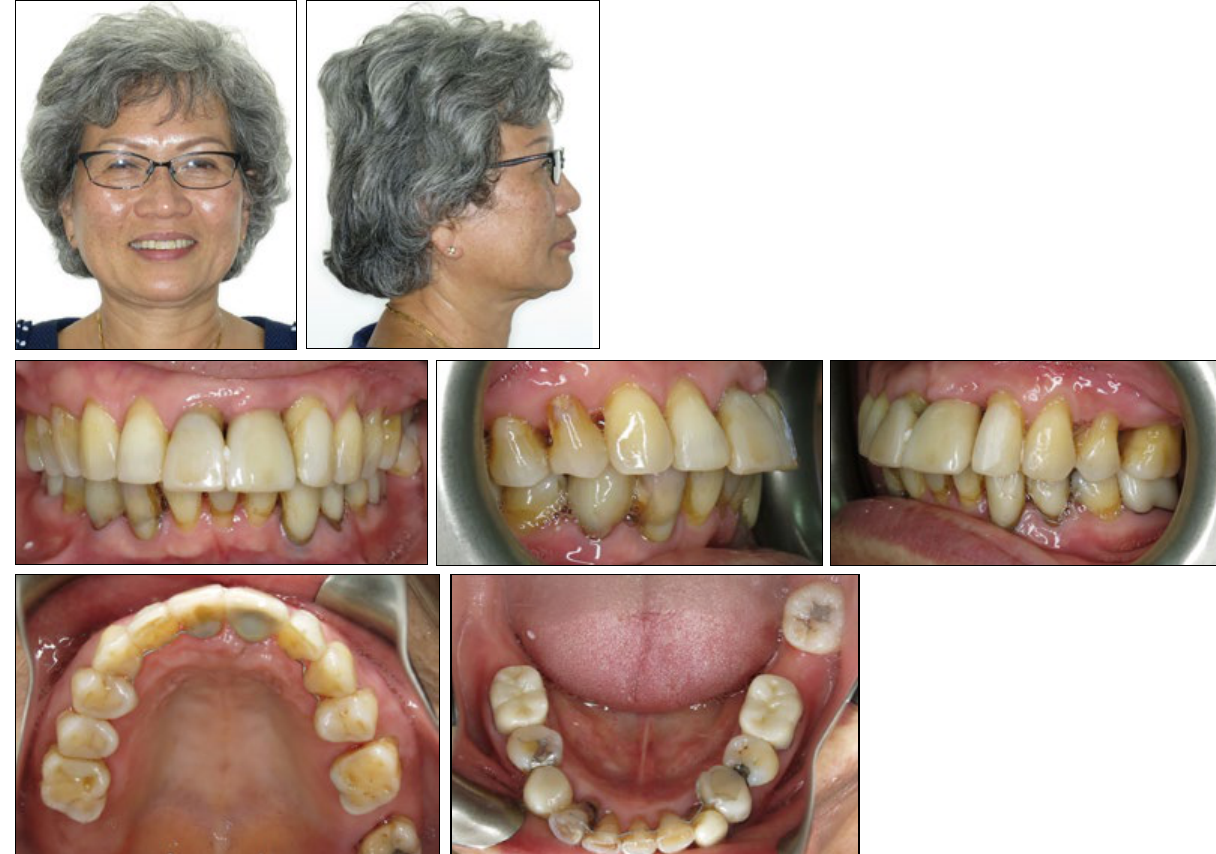
Figure 13. Post-treatment photographs taken at 28 months (nine months post-deband). The 21 implant has been restored with a ceramic